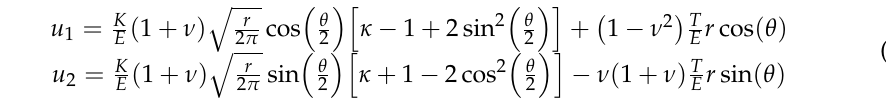
Figure 2. Boundary conditions.